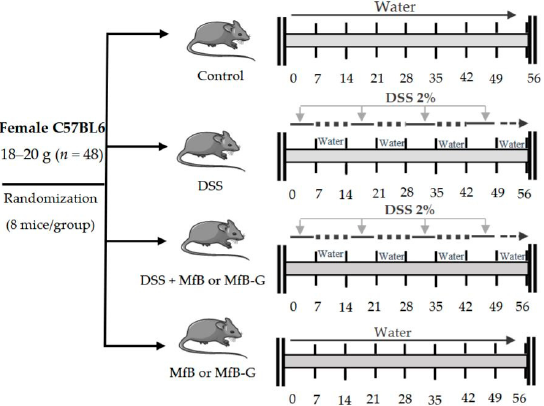
Figure 1. Experimental design of the chronic colitis induction by dextran sulphate sodium (DSS) (2%, w / v ) and plant sterol enriched milk-based fruit beverages without (MfB) or with galactooligosacharides (MfB-G) administration in the